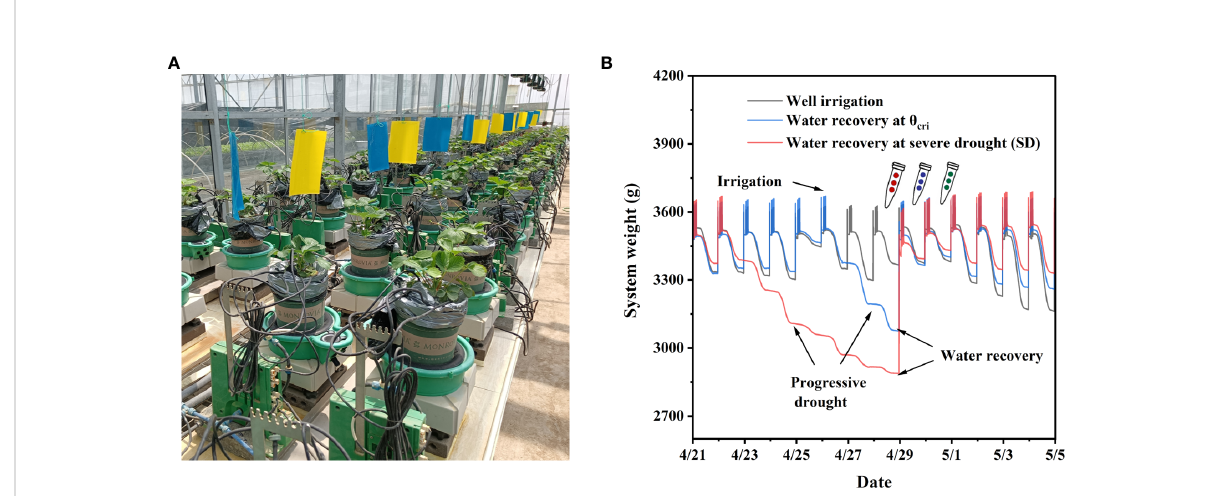
FIGURE 1 Strawberry experiments conducted with the high-throughput phenotyping platform “ Plantarray ” . (A) , Overview of the automated physiological phenotyping array loaded with strawberry seedlings. (B) , System weights that were recorded every 3 minutes during the experimental course. Three irrigation regimes are scheduling as well irrigation across the whole period (CK), water recovery at the critical threshold ( q cri ) when Tr starts to reduce signi fi cantly (WR_ q cri ), and water recovery at severe drought (WR_SD). The WR_ q cri and WR_SD experiments were divided into the well-irrigated, progressive drought, and water recovery